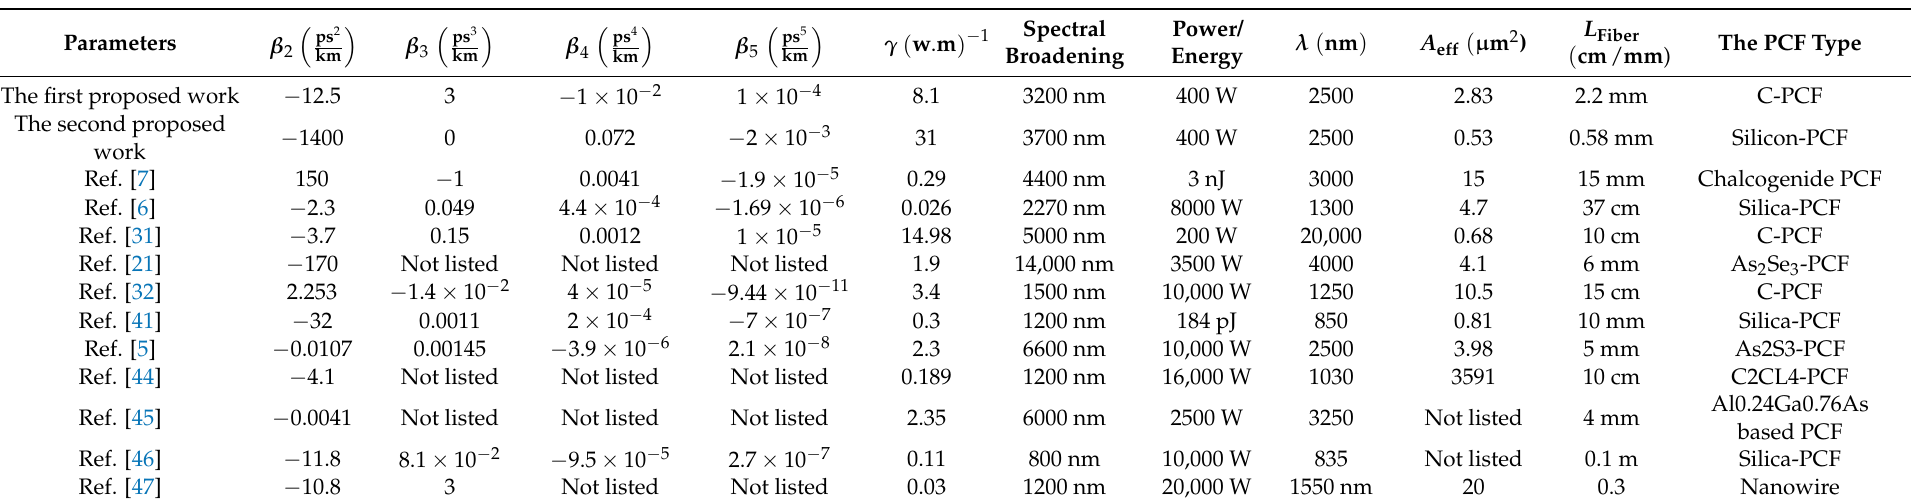
Table 2. Comparison between the results and other